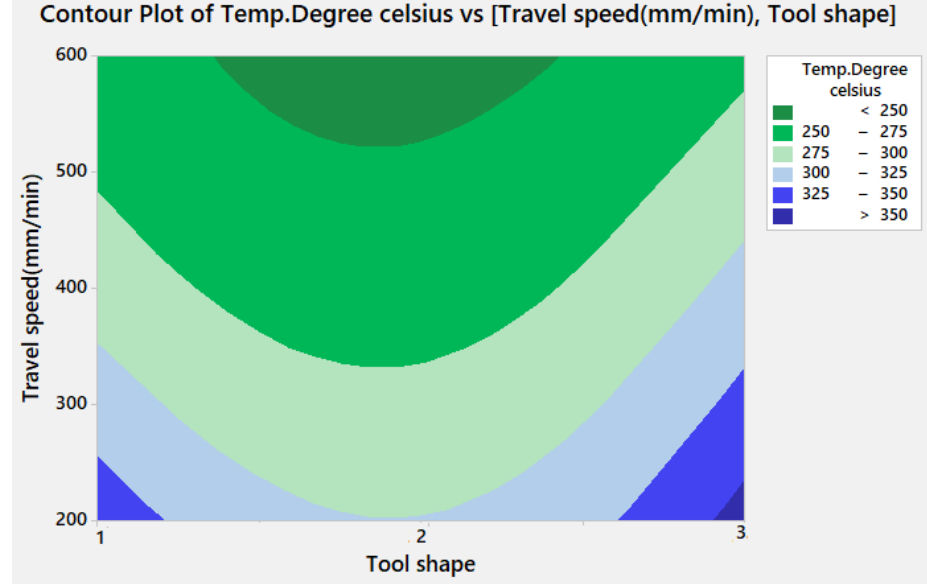
Figure 7. Mean S/N ratio for Tw.